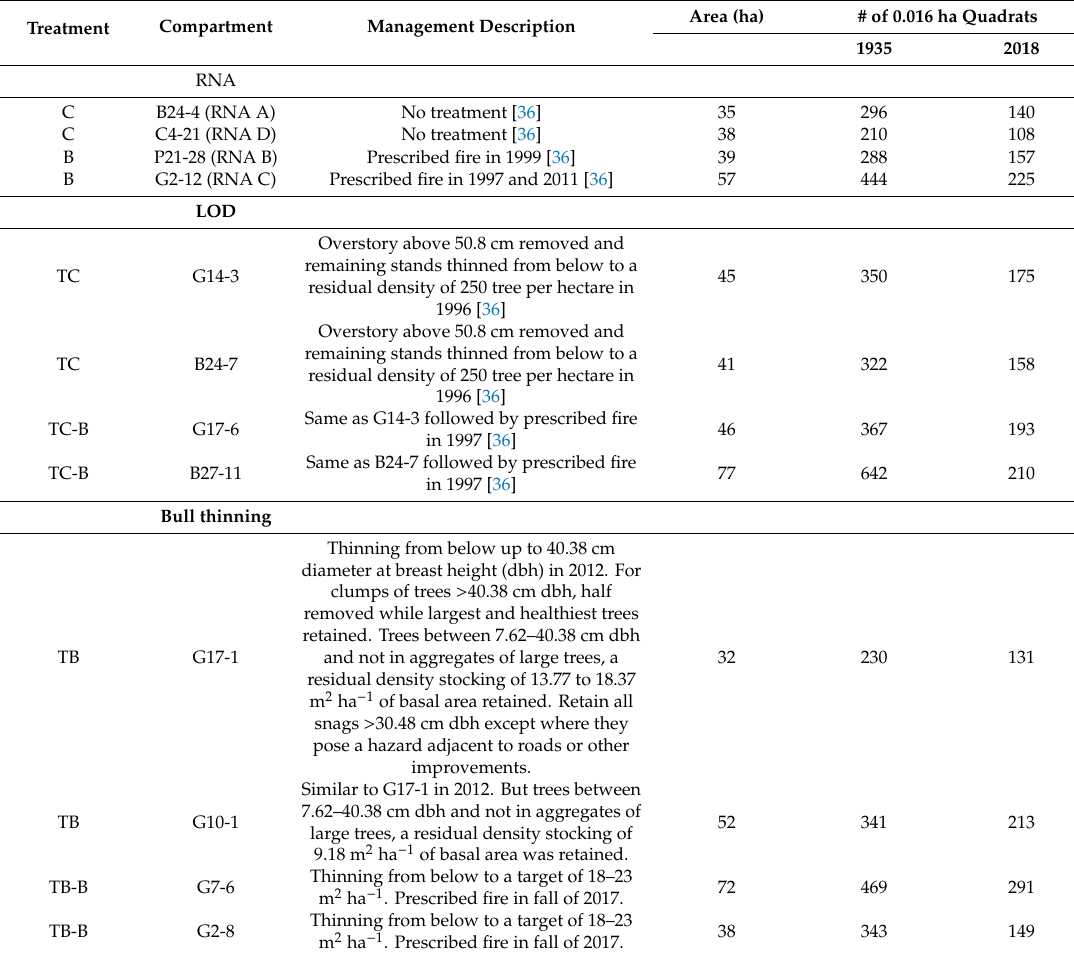
Table 1. Treatment, compartment name, management description, compartment area, and number of 0.0016 ha quadrats collected in 1935 and 2018 for each of the 12 compartments for which the non-parametric ANOVA and t -tests were